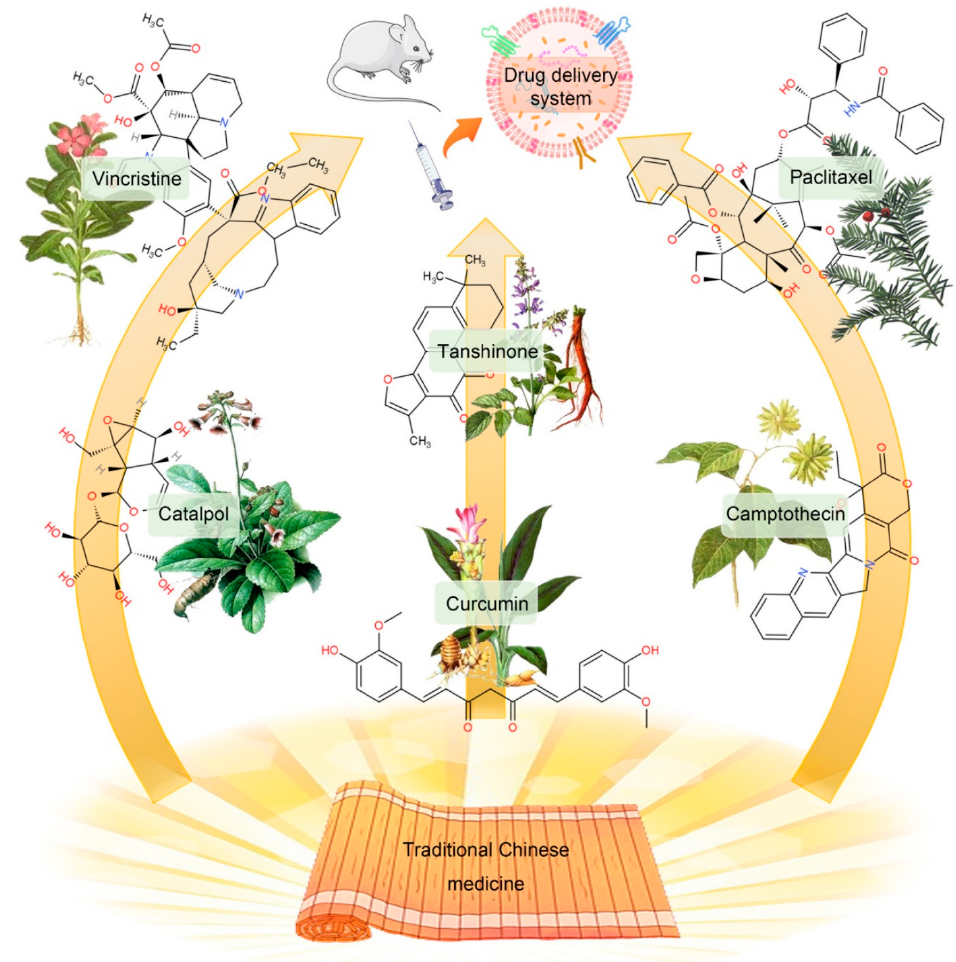
Figure 5. The monomeric active ingredients in TCM. Reproduced with permission from [120]. Copyright 2022, IVYSPRING.